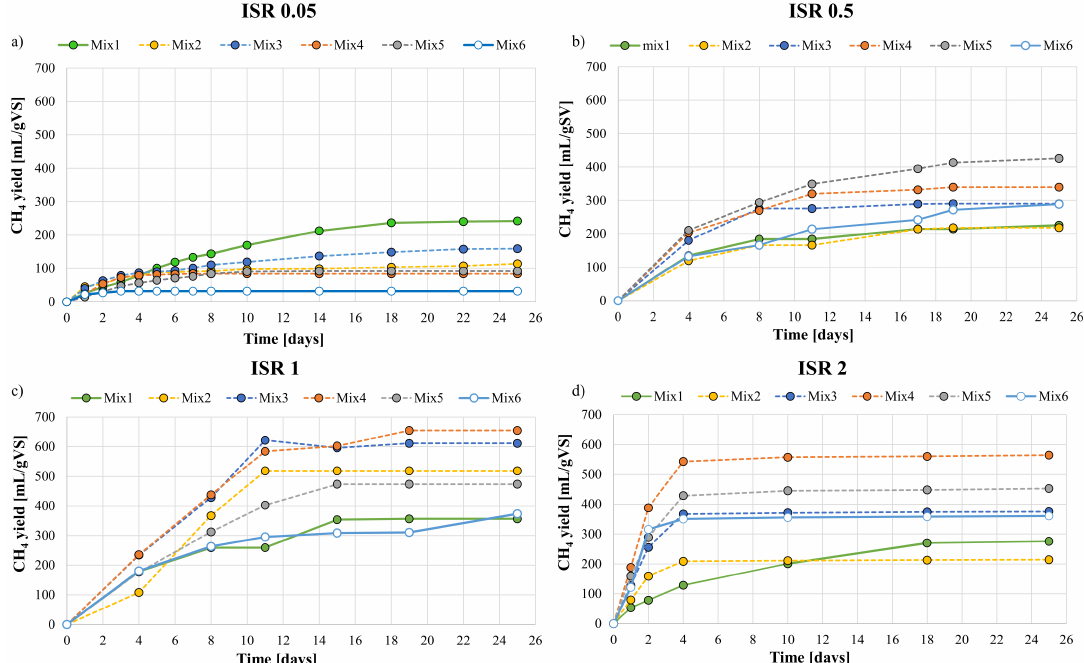
Figure 2. Cumulative methane yields curves of OFMSW and SS at: ( a ) ISR equal to 0.05; ( b ) ISR equal to 0.5; ( c ) ISR equal to 1; ( d ) ISR equal to